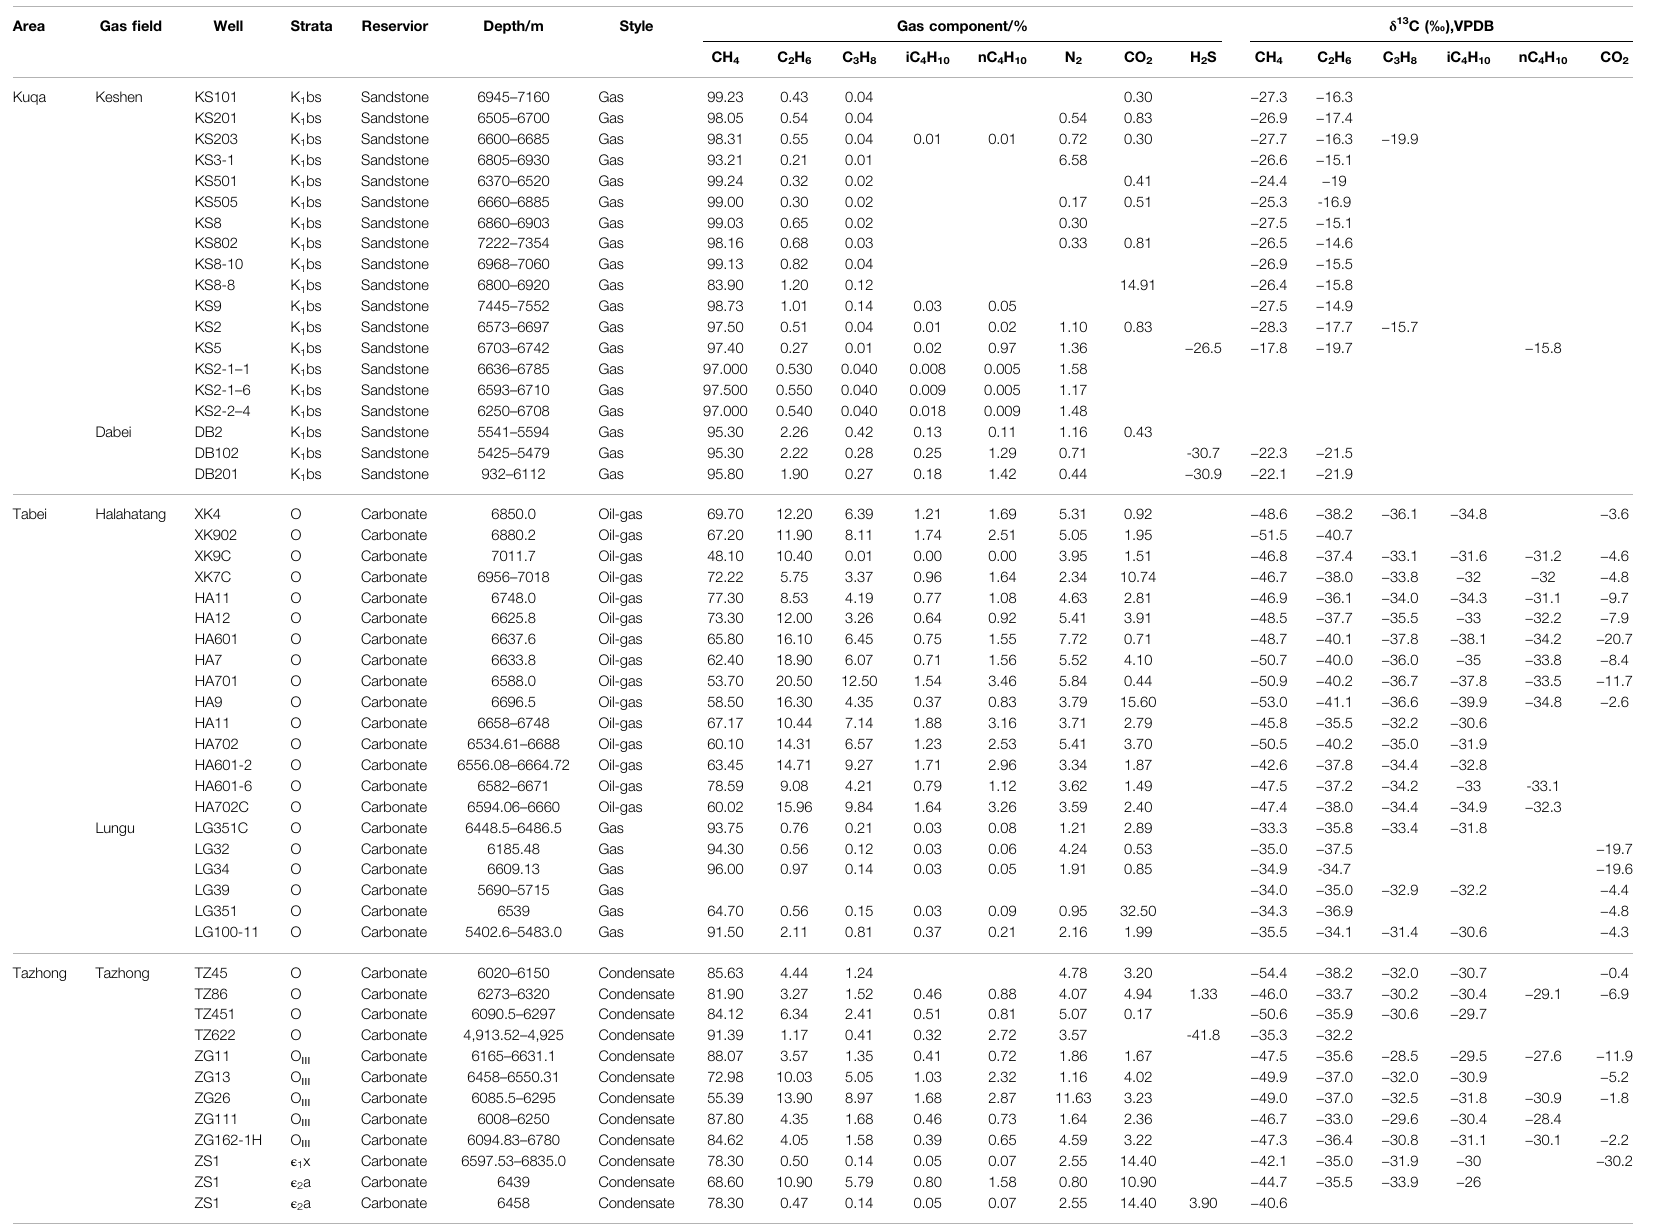
TABLE 1 | Geochemical data of natural gas deeper than 6000 m in the Tarim Basin. Area Gas fi eld